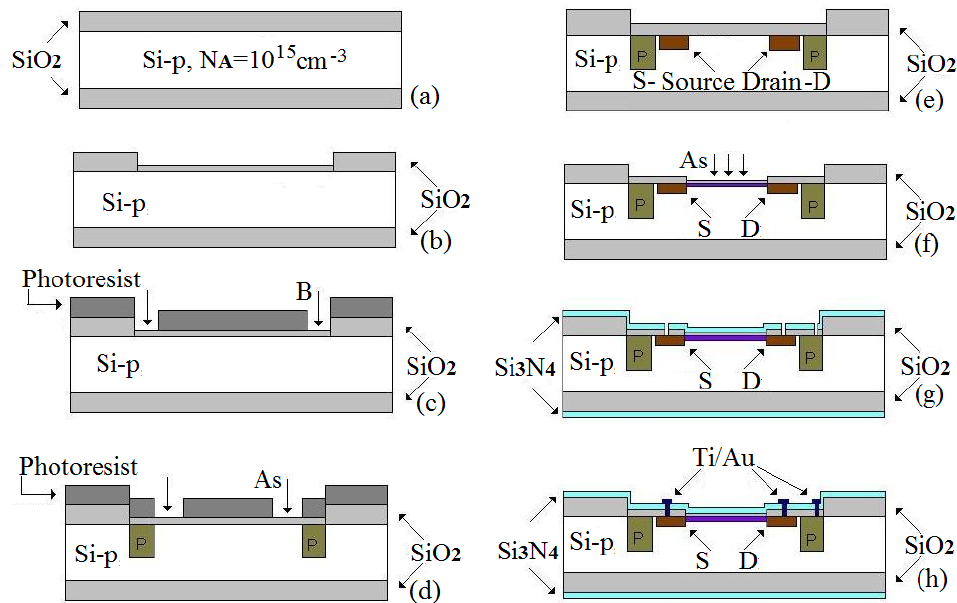
Figure 1. The successive technological steps during FETs processing. ( a ) thermal mask oxide grown ( b ) thin oxide grown in opened window ( c ) Boron implantation for p + − wells ( d ) As ( b ) thin oxide grown in opened window ( c ) Boron implantation for p + -wells ( d ) As implantation for implantation for n + − wells ( e ) annealing stages in oxidant atmosphere ( f ) correction channel n + -wells ( e ) annealing stages in oxidant atmosphere ( f ) correction channel implant ( g ) gate oxide implant ( g ) gate oxide realization and nitride layer deposition ( h ) metallic contacts con- realization and nitride layer deposition ( h ) metallic contacts figuration